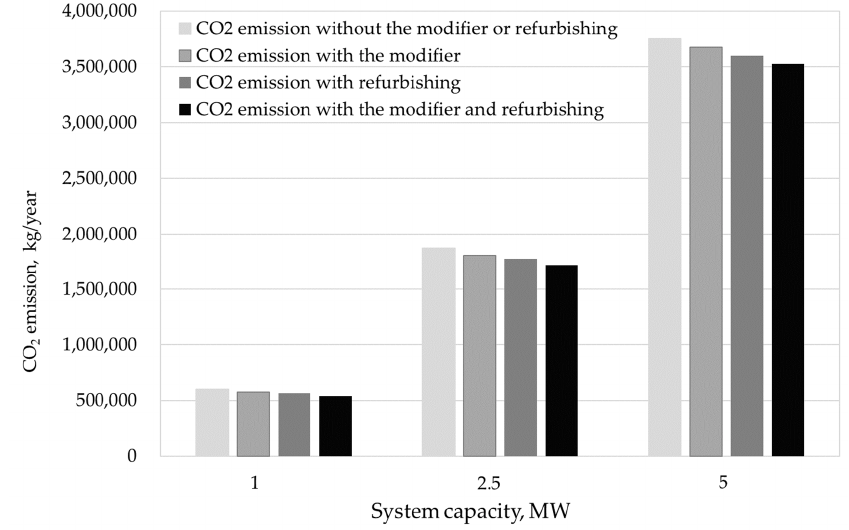
Figure 6. CO 2 emission in fuel oil combustion for system capacities from 1 MW to 5 MW.